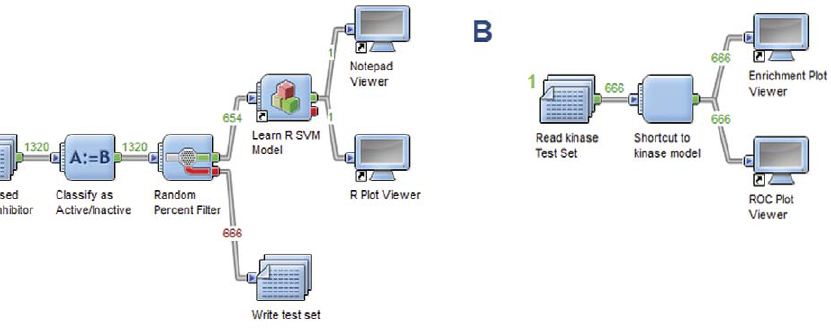
Figure 6. Pipeline pilot workflow used to carry out the SVM model using R statistics package. (A) Shows the usage of R-statistics node in pipeline pilot and its usage in learning the training set, after splitting, followed by giving the cross-validated ROC score via R plot viewer. (B) Shows the usage of the test set to validate the model using enrichment plot and R plot viewer.